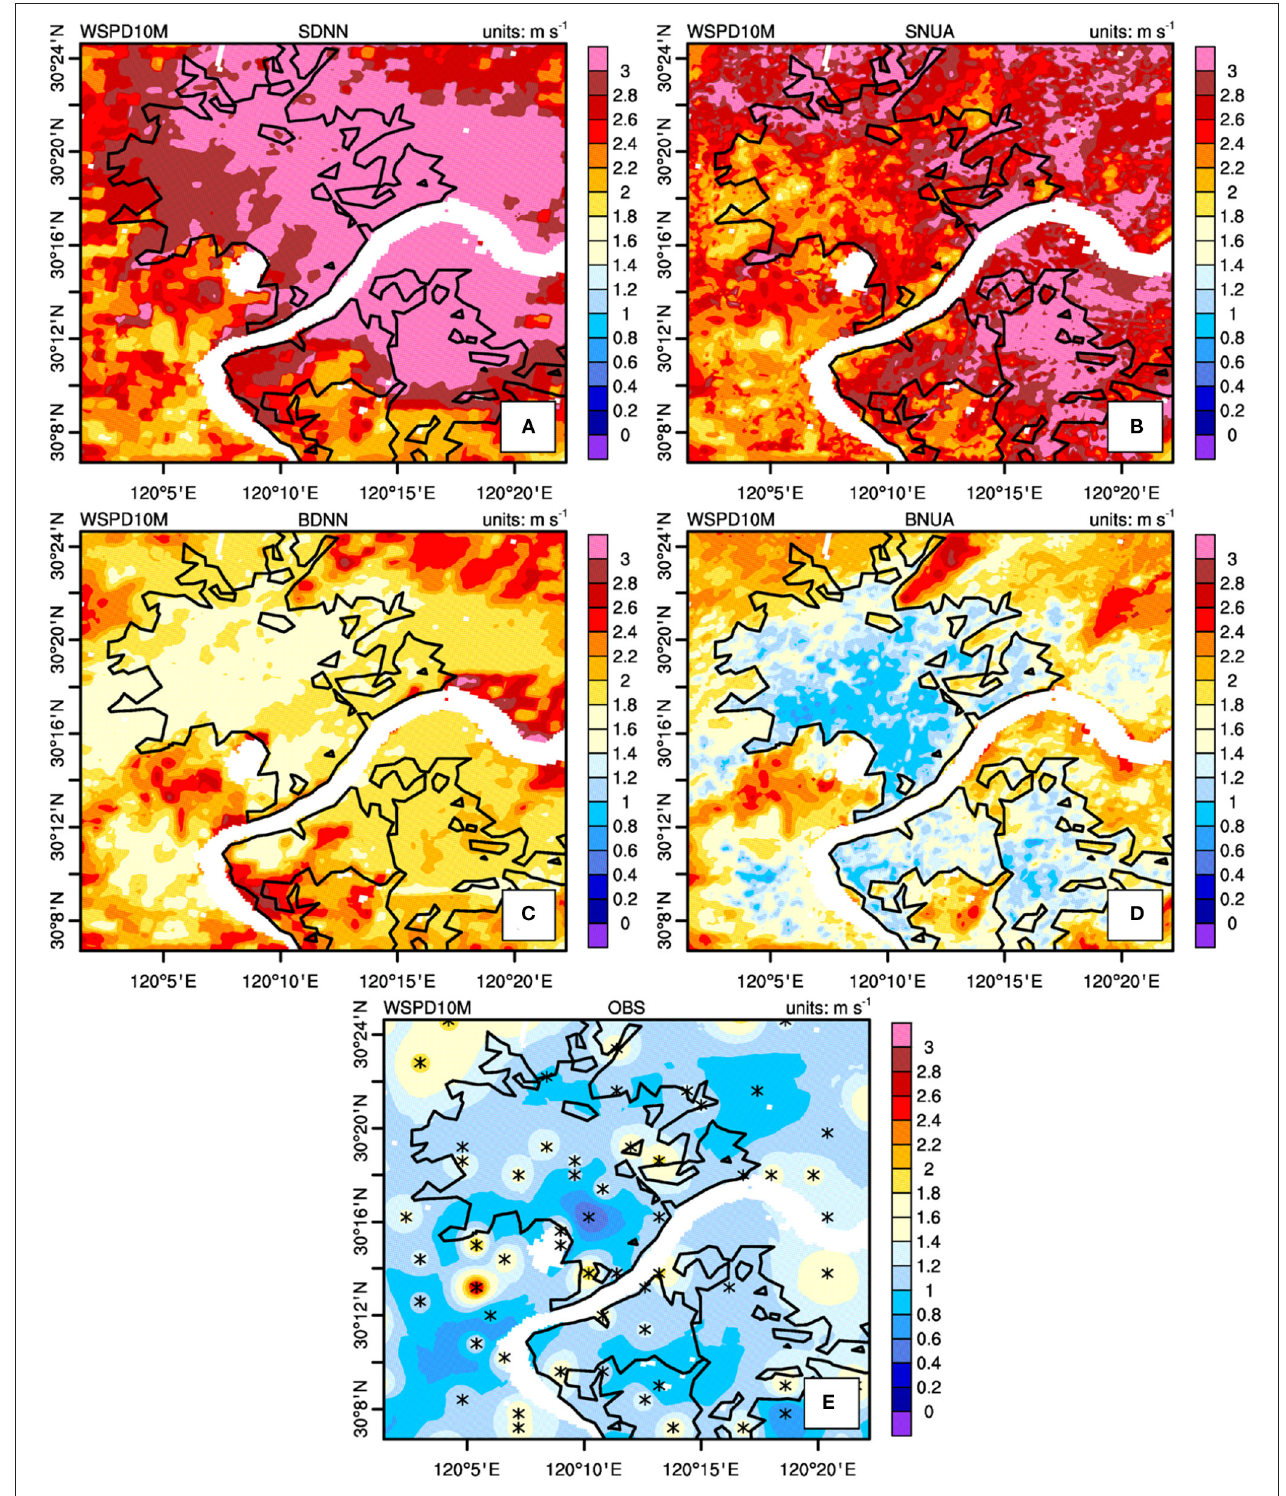
FIGURE 6 | The same as Figure 4 , but for daily mean wind speed at 10m.